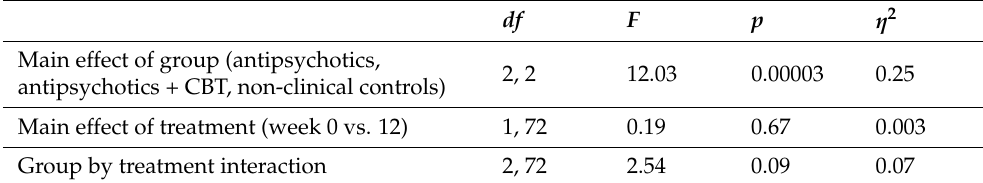
Figure 4. Temporal discrimination performance (mean probability of correct responses, 95% confi- dence intervals). Patients with schizophrenia were less accurate than controls both before and after treatment. (* week 0, controls vs. antipsychotics: p = 0.0001; controls vs. antipsychotics plus CBT: p = 0.002; week 12, controls vs. antipsychotics: p = 0.001; controls vs. antipsychotics + CBT: p = 0.01, Tukey’s test). Table 4. Summary of the results from the ANOVA conducted on the temporal discrimination performance (probability of correct answers).